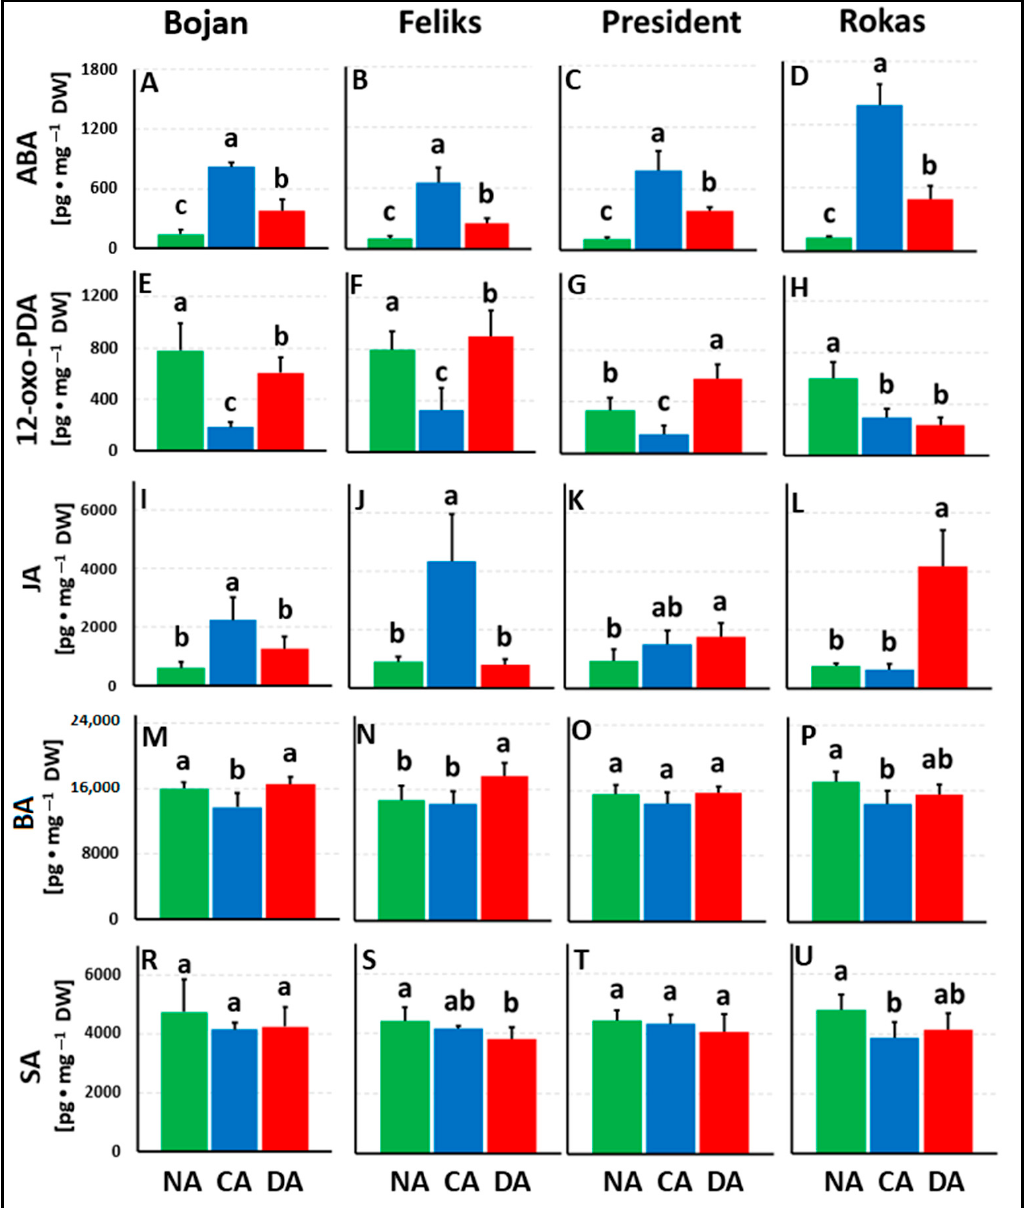
Figure 1. Content of the stress hormones: abscisic acid (ABA), jasmonic acid (JA), salicylic acid (SA) and selected precursors (12-oxo-phytodenoic acid (12-oxo-PDA) is a precursor of JA; benzoic acid (BA) is a precursor of SA) in four cultivars of the non-acclimated (NA), cold-acclimated (CA) and deacclimated (DA) oilseed rape. ( A – D )—ABA; ( E – H )—12-oxo-PDA; ( I – L )—JA; ( M – P )—BA; ( R – U )—SA. Values marked with the same letters (within each cultivar separately) were not significantly different according to the Duncan test ( p ≤ 0.05).